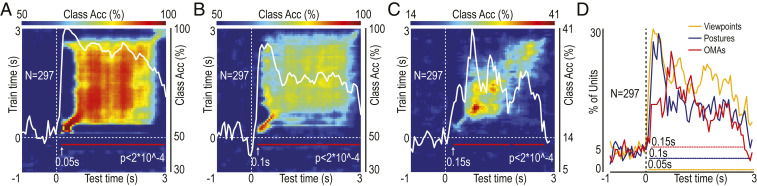
Population decoding of viewpoint, actor’s body posture, and OMA exemplar. (A) Classification accuracy of viewpoint (lateral and frontal, regardless of actor’s body posture and OMA). (B) Classification accuracy of actor’s body posture (standing and sitting, regardless of viewpoint and OMA). (C) Classification accuracy of OMA exemplars (regardless of the format). The decoding accuracy (color-coded) is expressed as a function of test and train time. The superimposed white lines represent the classification accuracy along the diagonal (scale; Right); the red lines indicate the period during which the decoding accuracy is significantly above chance level (beginning of the first 150-ms significant bin; Materials and Methods). (D) Percentage of units (out of the entire population) showing significant tuning for viewpoint, actor’s body posture, and OMAs (repeated-measures ANOVAs in 150-ms bins shifted forward in steps of 50 ms). Colored dashed lines highlight bins with a fraction of tuned units significantly higher than during baseline (χ2, P < 0.05).